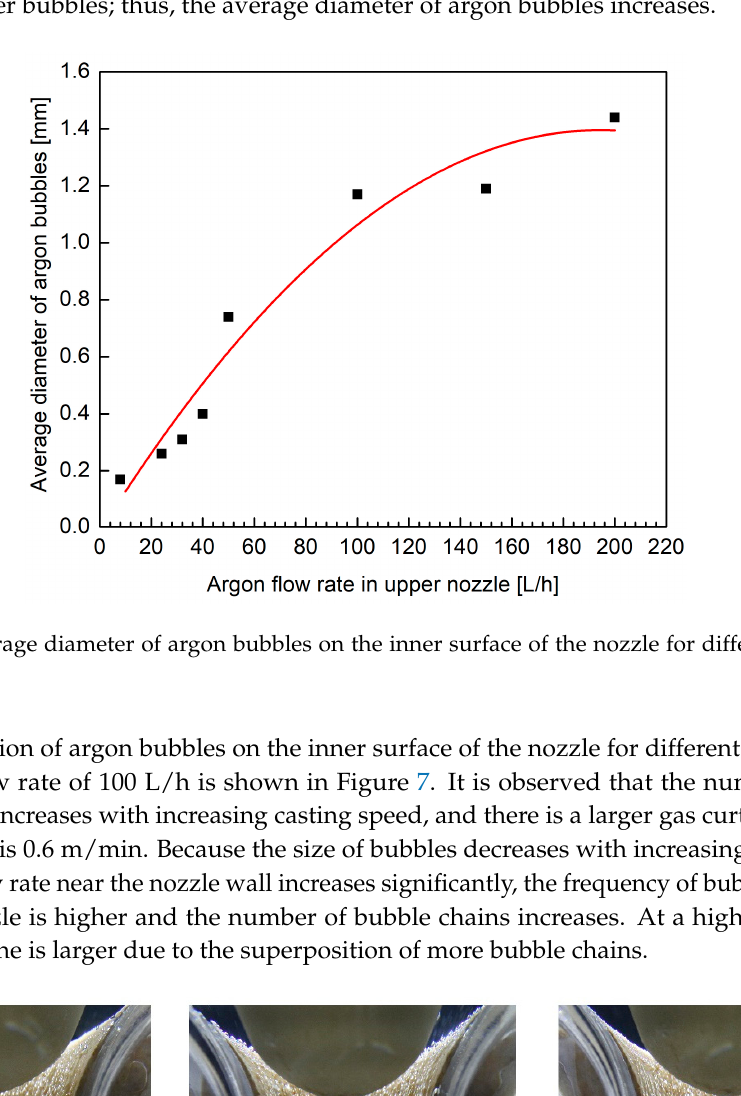
Figure 7. Distribution of argon bubbles on the inner surface of the nozzle for different casting speeds: ( a ) 0.4 m/min; ( b ) 0.5 m/min; ( c ) 0.6 m/min.